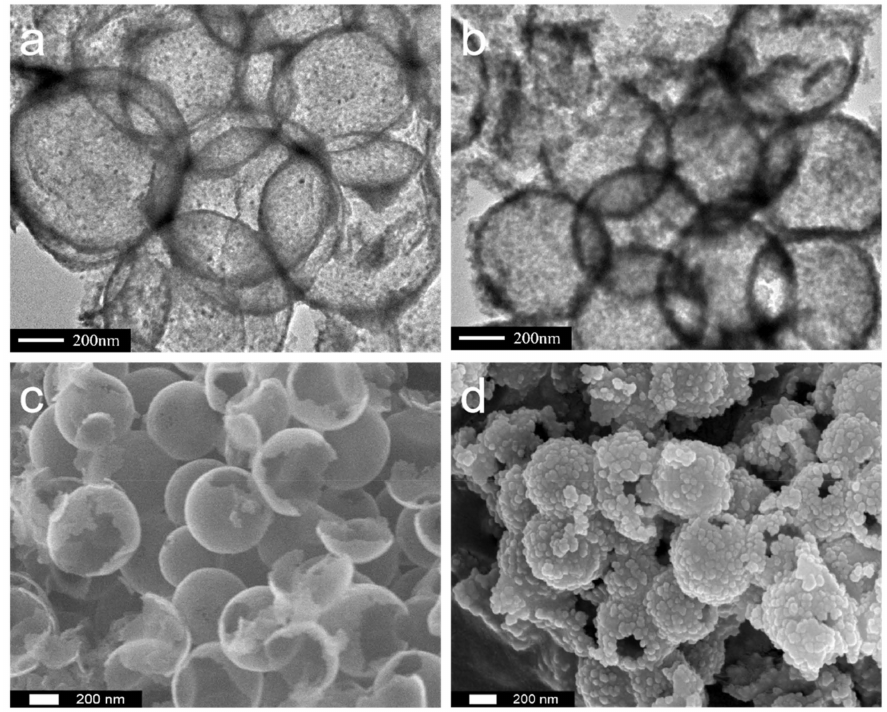
Figure 1. TEM and SEM images of hollow TiO 2 spheres ( a , c ) and HTM spheres ( b , d ).